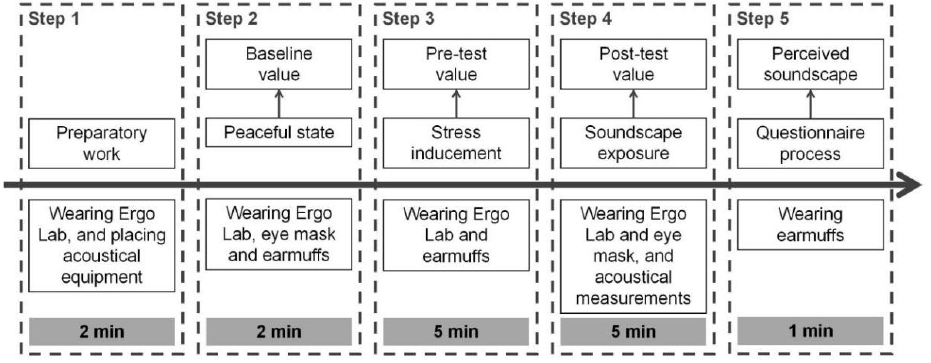
Figure 2. Measurements time stamp for gathering